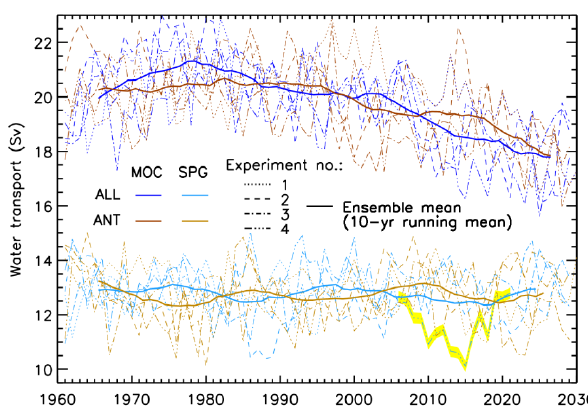
Fig. 9. Variation of the MOC (dark colours, top set of lines) and the subpolar gyre (light colours, bottom set of lines) in the HadGEM1 experiments. The SPG index of ALL 4 has been highlighted from